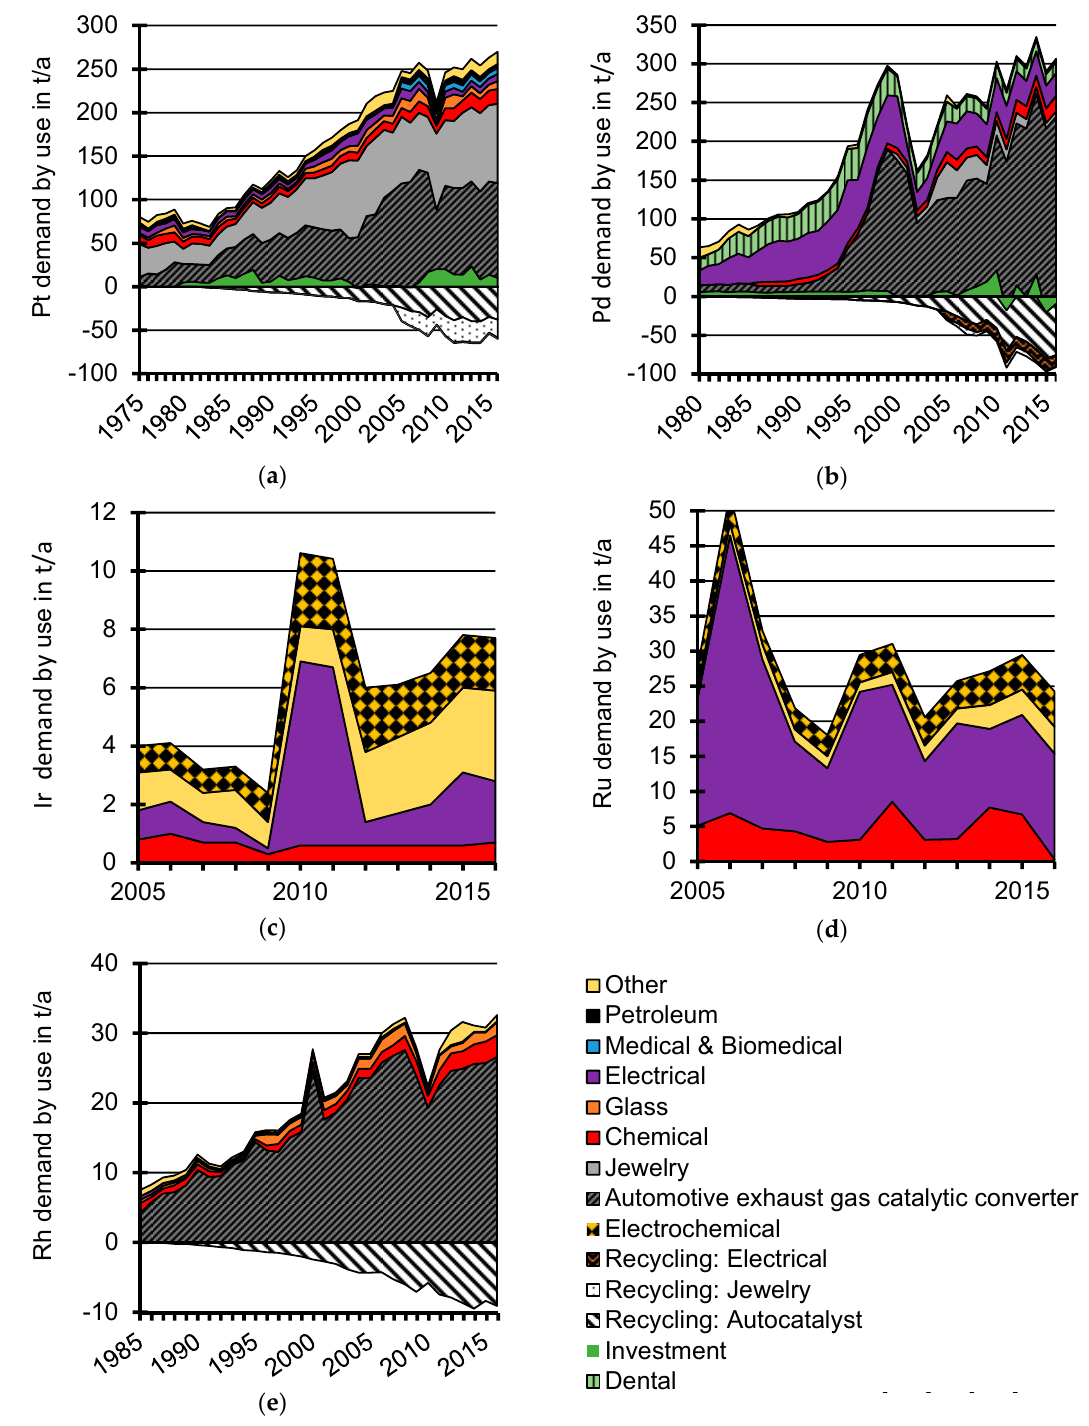
Figure 1. Global Pt ( a ), Pd ( b ), Ir ( c ), Ru ( d ) and Rh ( e ) demand from 1975, 1980, 2005 and 1985, respectively, to 2016 (before 1980, investment demand for Pt is contained in our “Other” estimates; before 2005, “Jewelry” and “Electrical” demand for Pt is the net of recycling, “Medical & Biomedical” is contained in “Other”; before 1986, the Pd demand of the chemical industry is contained in “Other” estimates) [18,41].